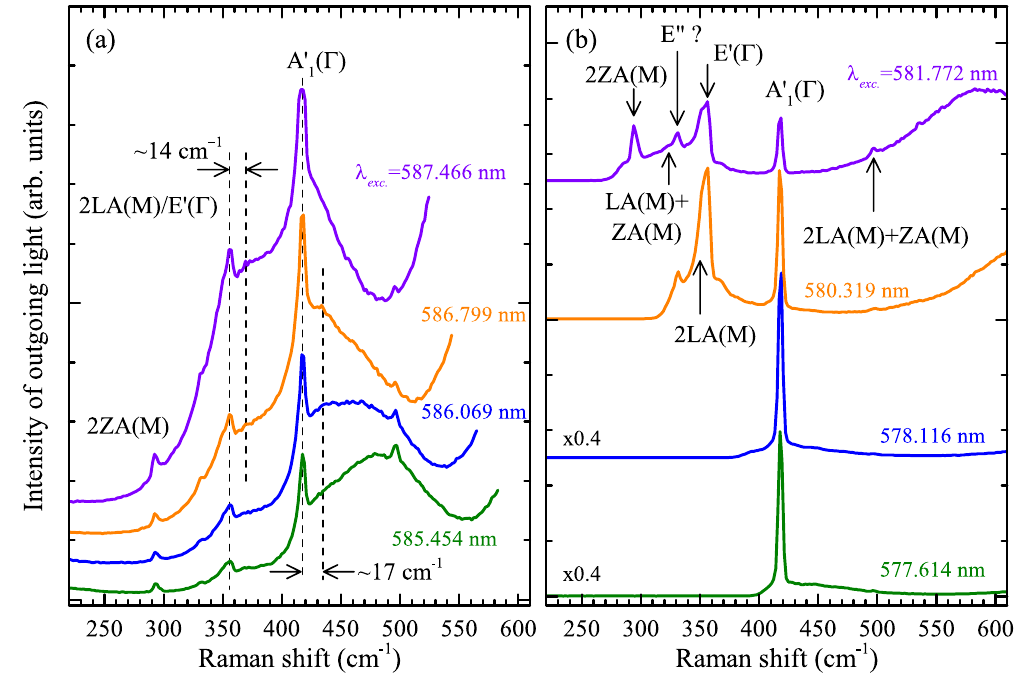
Figure 5. Optical response of monolayer WS 2 at T = 5 K excited with laser light of different wavelengths falling in the energy range of ( a ) charged and ( b ) neutral